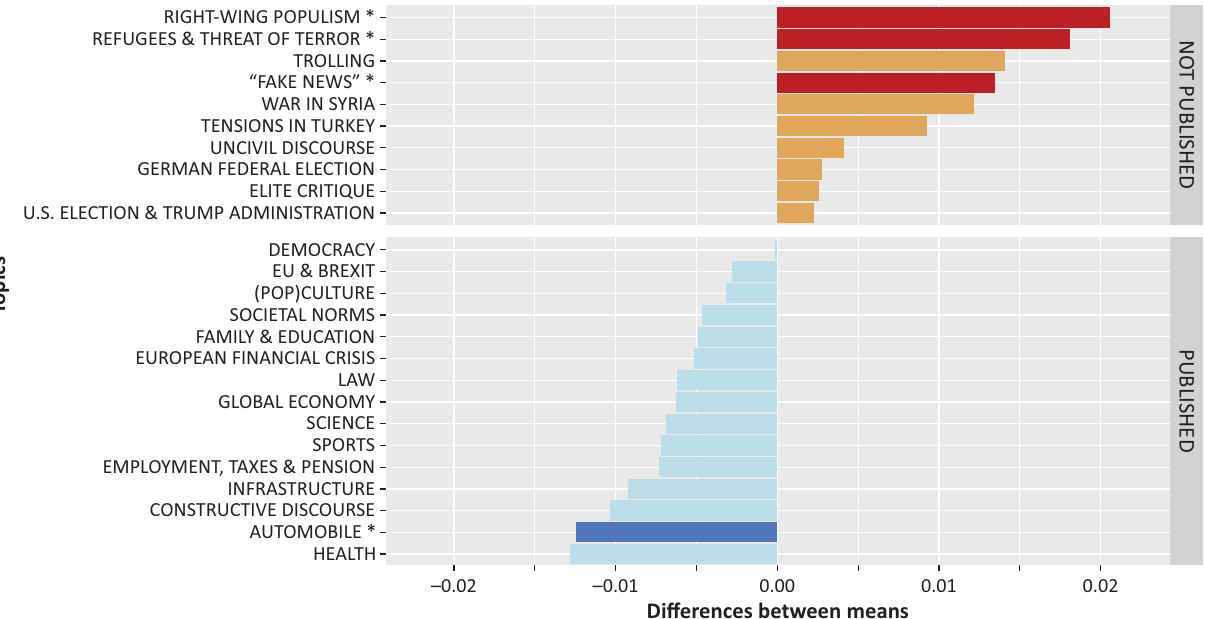
Figure 1. Equivalency among topic and gatekeeping decision on the comments that include swearing. N = 58 , 176, Δ = 0 . 1; * p < 0 . 05, ** p < 0 . 01, *** p < 0 .